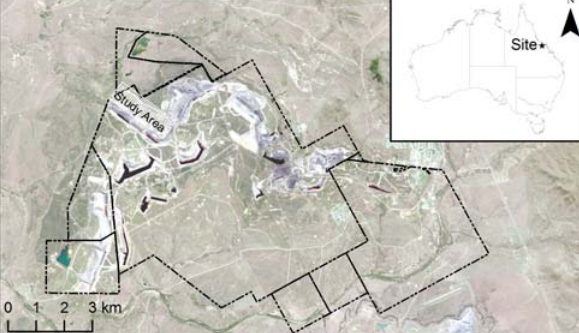
Figure 1. Site location (inset (cid:144) ) and study area (white hash) relative to mine lease